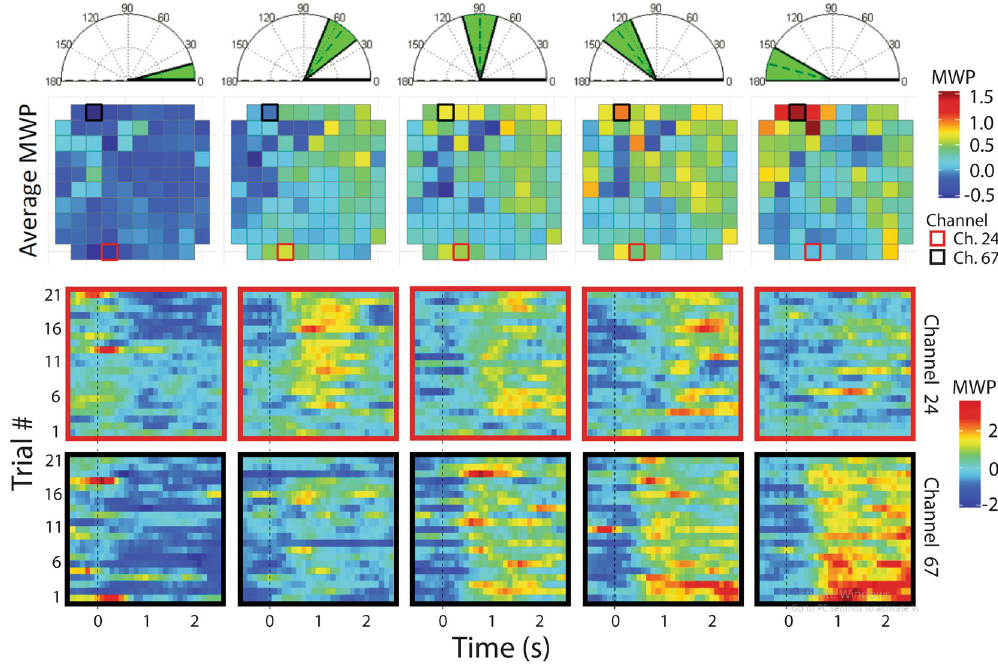
Figure 2. Imagined graded muscle contractions modulates neural activity in M1. The top row shows the angle cue that was presented visually to the participant. Each column corresponds to the cue from the top row. The second row shows the mean MWP superimposed on the layout of the MEA. The MWP is averaged over each trial from 0.5 s after cue presentation to 2.5 s after cue presentation. The third row shows the temporal evolution of MWP for each of the 21 trials (for the rest cues we show the first 21 trials) for Channel 24 from 0.5 s before the cue until 2.5 s after the cue. The dashed line at 0 s represents the time of cue presentation. Channel 24 shows a pattern of low MWP for the rest angle, high MWP activity at the lower non-zero angles and decreasing MWP activity as the angles increase. The last row follows the same format as above but represents Channel 67, which shows increasing MWP activity with increased